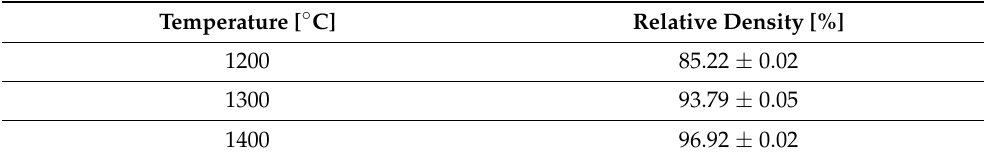
± confidence interval at confidence level 95%.